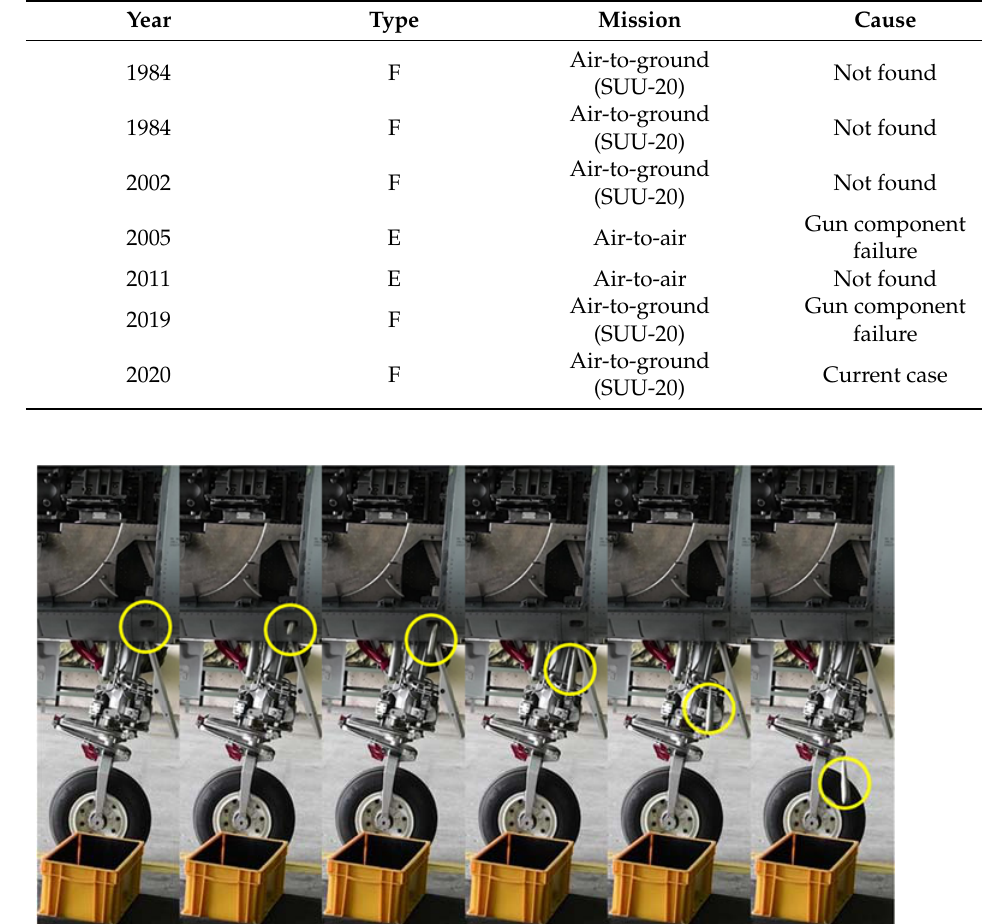
Table 1. Historical data of shell case collisions with aircrafts.